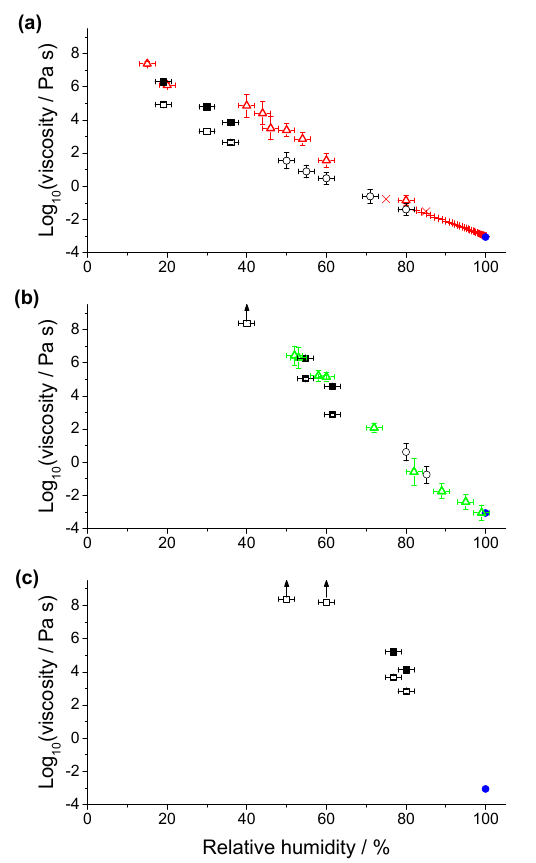
Figure 6. Plot of log 10 (viscosity/Pas) vs. relative humidity for (a) glucose, (b) raffinose, and (c) maltohexaose. Viscosities mea- sured here are shown in black; circle symbols correspond to mea- surements made using the bead mobility technique, with error bars corresponding to an uncertainty of 2 σ , and square symbols corre- spond to the lower (open symbols) and upper (filled symbols) limits of viscosity determined using the poke-and-flow technique, with un- certainties corresponding to 95% confidence intervals. The viscos- ity of water (Haynes, 2015) is shown as a blue circle in each panel. Additional literature viscosities are represented with the following symbols: regular crosses (Haynes, 2015; Achard et al., 1992), diag- onal crosses (Barbosa-Canovas et al., 2007), and upward-pointing triangles (Song et al., 2016).